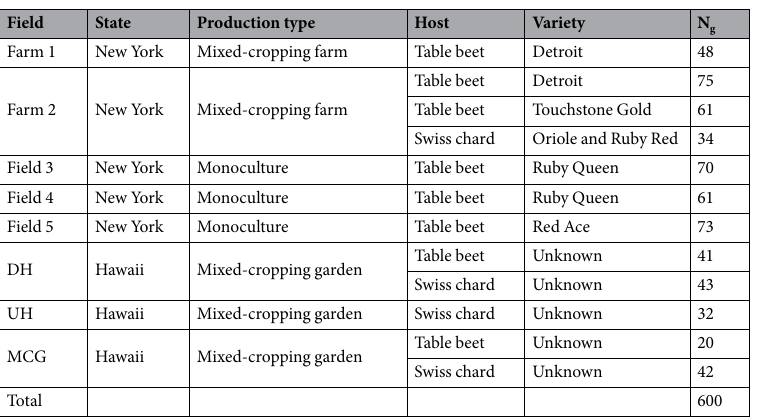
Table 1. Sampling locations and hosts of Cercospora beticola isolates collected in 2015, and the total number of isolates genotyped (N g